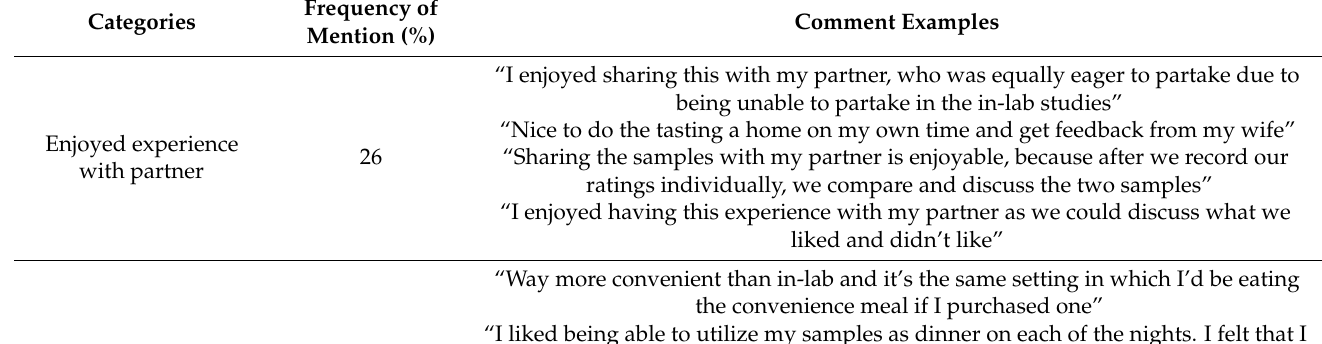
Table 7. Categories, frequency of mention and some comment examples from the participants of the study ( n = 50).